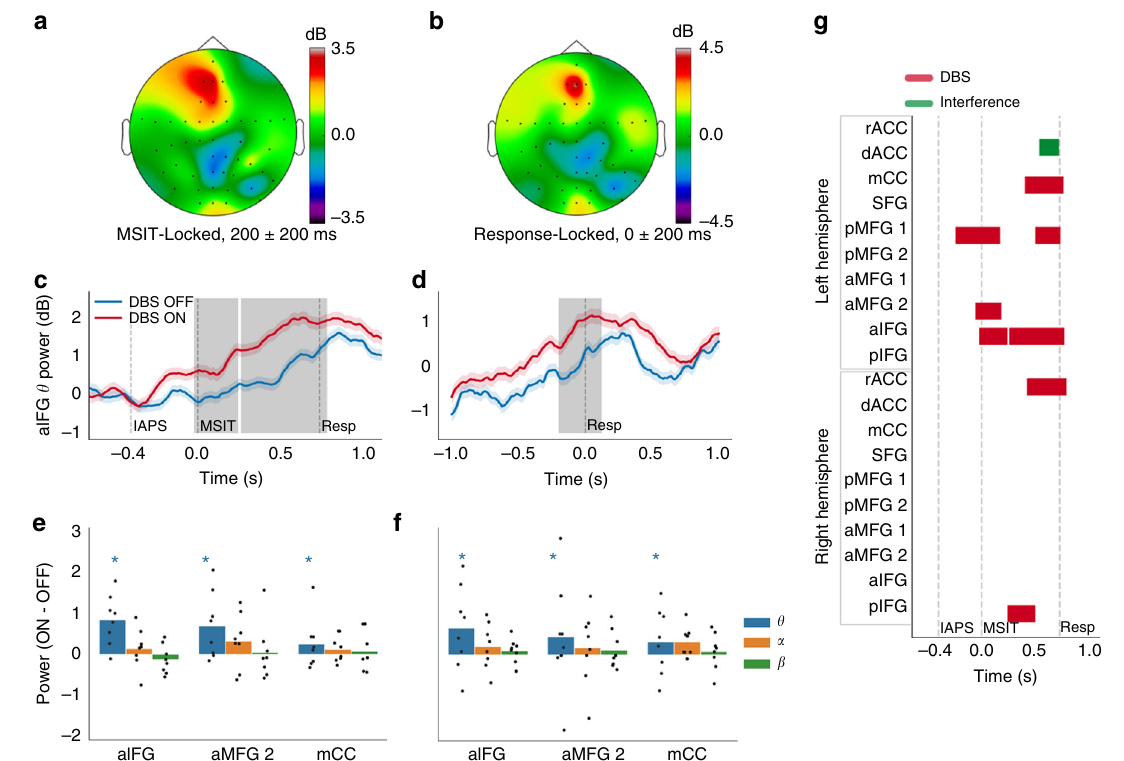
Fig. 3 Deep brain stimulation (DBS) increases task-evoked frontal theta oscillations. a , b Topographic plots of a stimulus- and b response-locked theta power. c , d Theta time courses in left anterior inferior frontal gyrus (aIFG), locked to c stimulus presentation or d response. Shading is standard error of the mean from 1000 bootstraps. Gray bars indicate signi fi cant cluster masses from sliding regression at p < 0.05, corrected via permutation testing. e , f DBS ON-OFF theta (4 – 8 Hz), alpha (8 – 15 Hz), and beta (15 – 30 Hz) change during the a , b time windows, in three example labels, ( e ) stimulus and f response locked. Error bars denote standard error of the mean. Stars denote the presence of a p < 0.05 cluster as in c , d , which may not necessarily be during this illustrative time window. Thus, signi fi cance in this plot does not directly correlate with the means and error bars, but correlates with the more rigorous statistics of c , d and g . Individual points re fl ect change in power for each patient. g Extents of signi fi cant DBS and interference clusters. a/A anterior, d dorsal, I inferior, m/M medial, r rostral, S superior, CC cingulate cortex, FG frontal